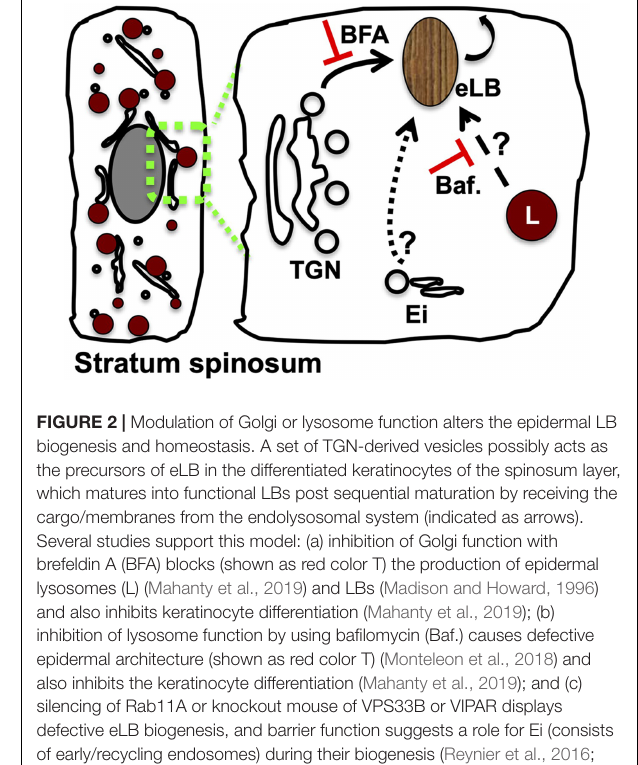
in Raposo et al., 2007; Marks et al., 2013; Bowman et